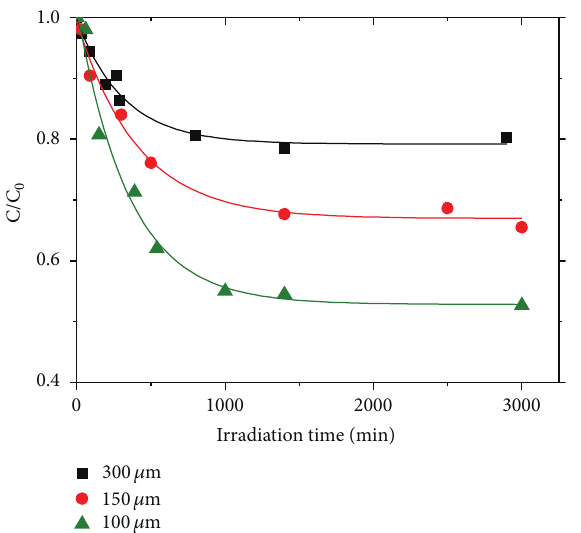
Figure 2: Degradation of mesotrione at the surface of various thick- nesses of Kaolinite. Irradiation performed in Sunlight simulator. [Mesotrione] = 5.2 𝜇 molg −1 .